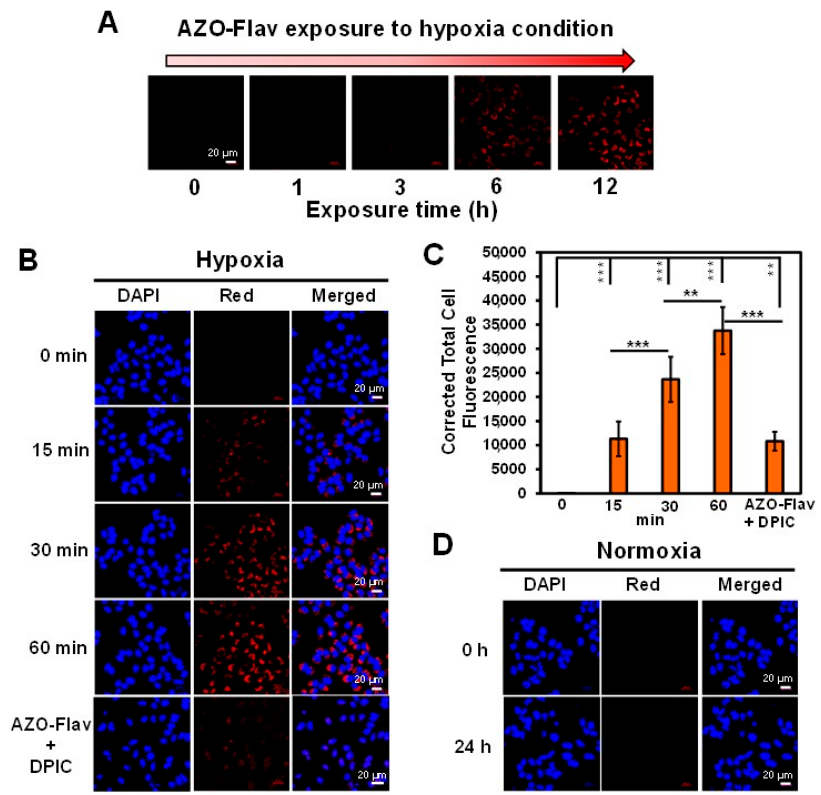
Figure 6. Confocal images of HepG2 cells. ( A ) Different exposure times (0, 1, 3, 6, and 12 h) of HepG2 cells in hypoxic conditions. ( B ) Time dependent hypoxia detection, with hypoxic cells incubated with 5 μ M of AZO-Flav for 0, 15, 30, and 60 min. DPIC (50 μ M) was added after 60 min incubation to inhibit electron transfer. ( C ) Quantitative corrected total cell fluorescence data of images in B were quantified using ImageJ and represent the mean ± SD (n = 100 from three independent experiments). ( D ) The cells incubated with 5 μ M of AZO-Flav for 0 and 24 h under normoxia. Statistical analysis: One-way ANOVA followed by Tukey’s post-hoc analysis was used for comparison between multiple groups using R studio. P values of less than 0.05 are considered significant (** p < 0.01, *** p < 0.001). After incubation in a hypoxia incubator chamber for 12 h, the cells were treated with AZO-Flav for different time durations (15, 30, and 60 min). The fluorescence signal of